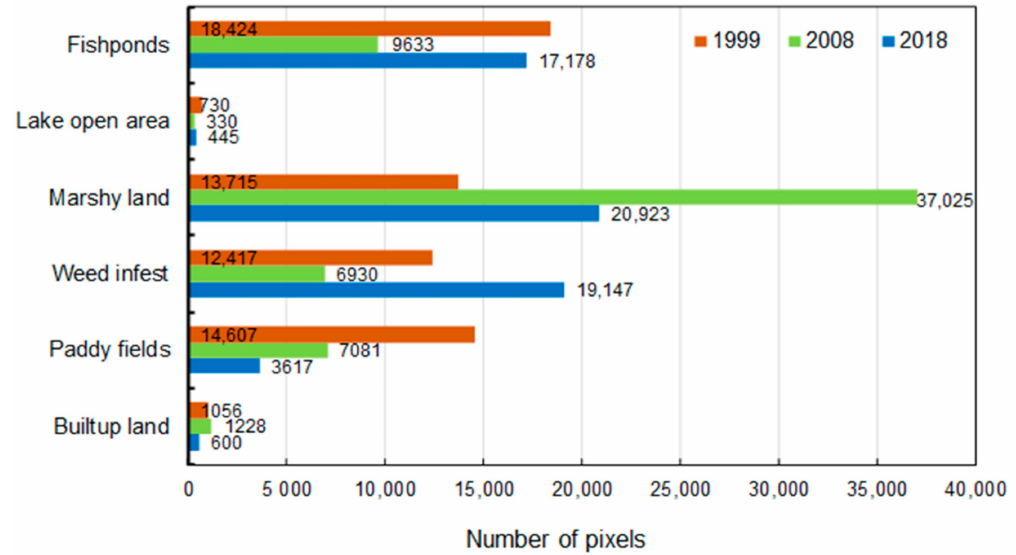
Figure 8. Land use change in the Kolleru Lake wetland between 1999 and 2018 (Figure